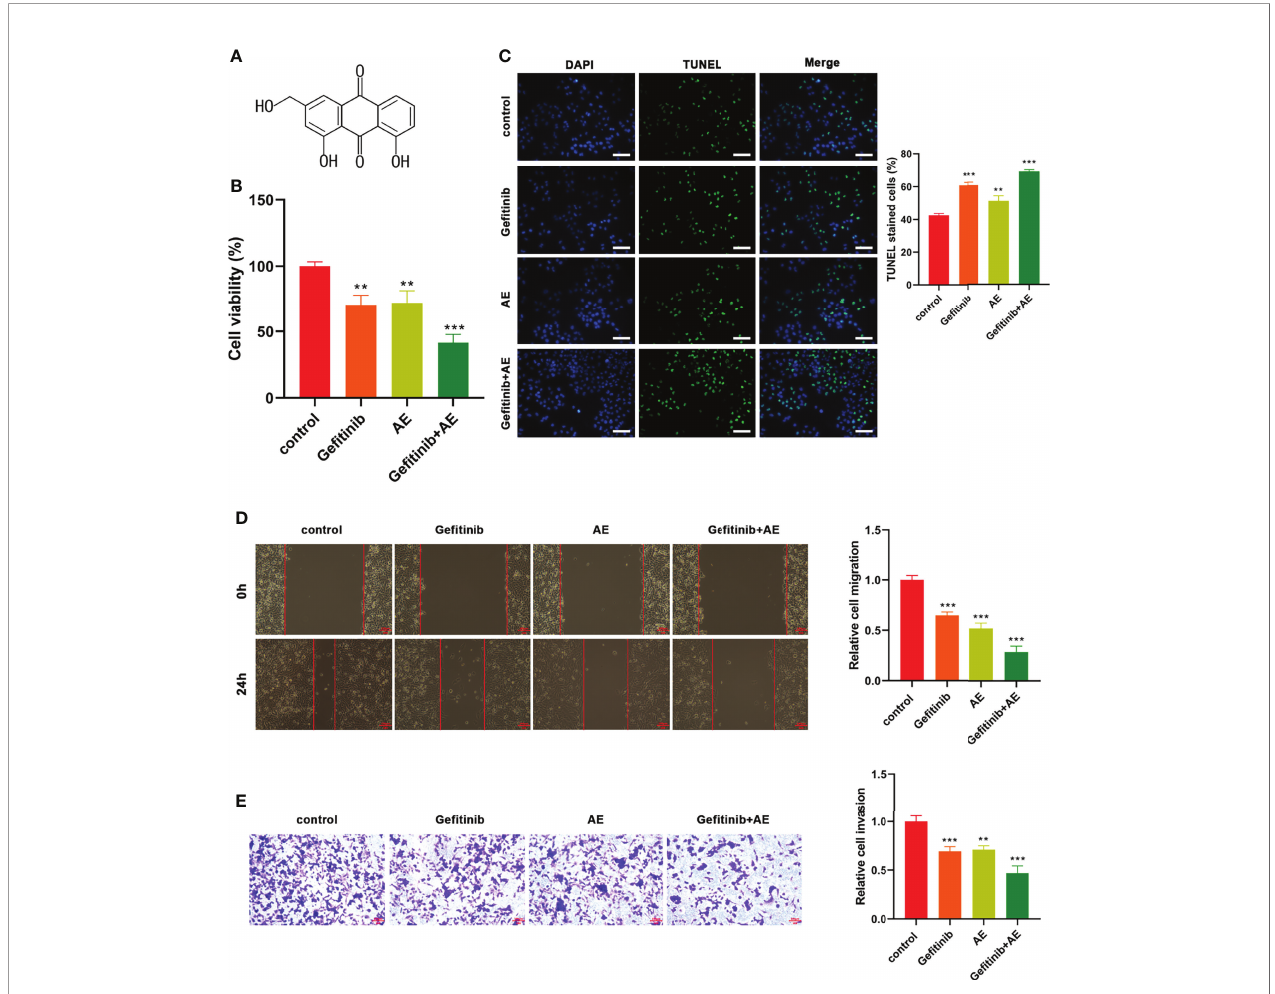
FIGURE 2 | AE Could Enhance the Ge fi tinib Sensitivity of PC9-GR Cells. (A) Chemical structure of AE. (B) CCK8 results, (C) TUNEL assay results, (D) wound healing assay results, and (E) Transwell assay results of PC9-GR cells after different treatments. Scale bar = 100 m m. **p<0.01,